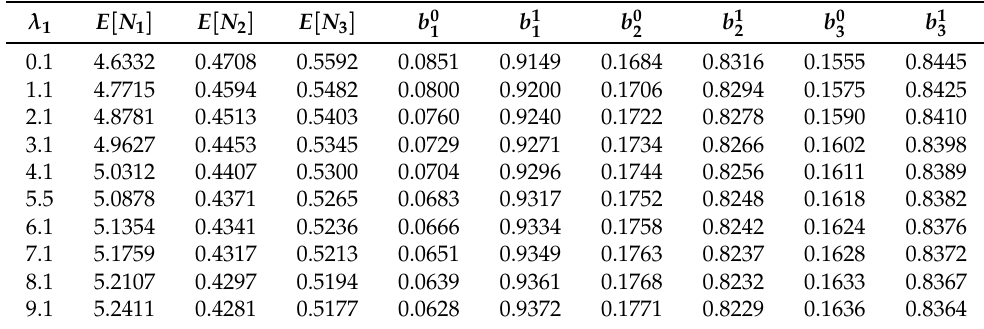
Table 10. Effect of λ 1 on various performance measures.